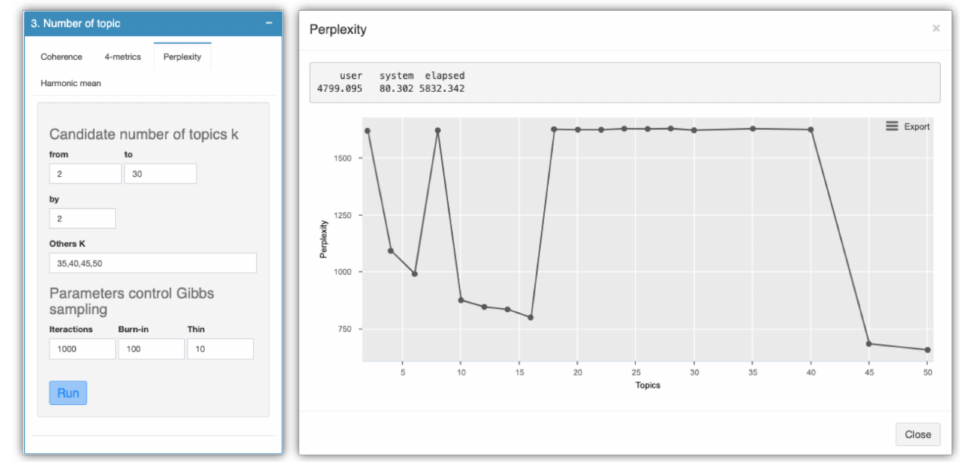
Figure 6. Configuration options used to calculate the number of topics